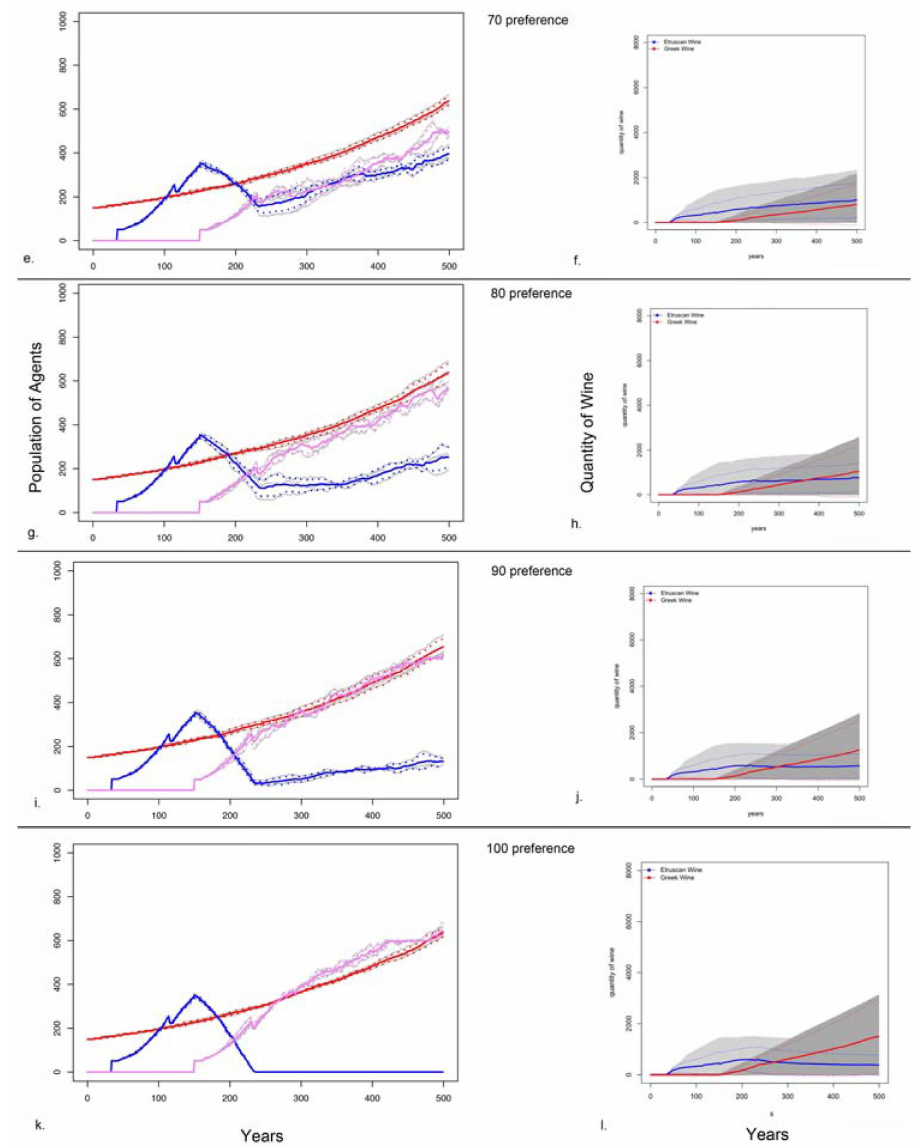
Figure 5. ( a – l ) Response of population and artifact type based on preference value, beginning at preference of 50 (no preference for Greek or Etruscan wine) and ending at 100 (preference for Greek wine). Preference values are reported in the middle of each tile, corresponding to the values on the left and the right. Left side of tiled figure corresponds to population, while the right side corresponds to the artifact assemblage. Solid colored lines denote the mean, while dotted colored lines denote one standard deviation above and below the mean. Grey lines indicate overall variation of output in